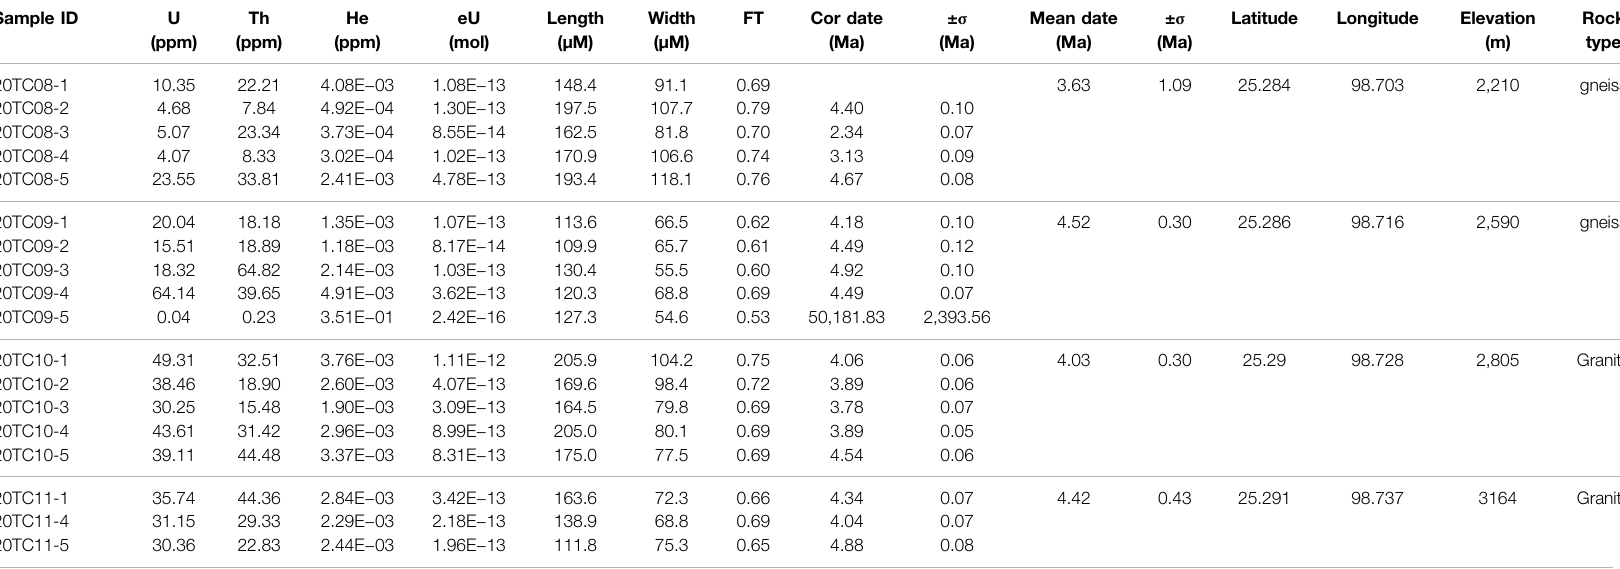
TABLE 1 | Results of the apatite single particle (U-Th)/He analysis in the Gaoligong ductile shear zone (GLGSZ). Sample